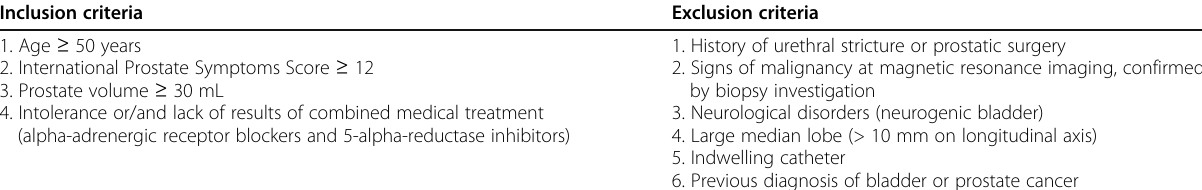
Table 1 Inclusion and exclusion criteria Inclusion criteria Exclusion criteria